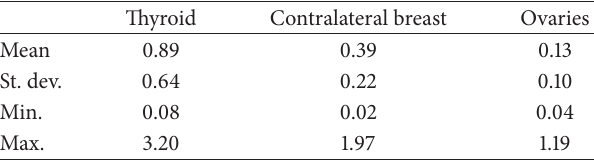
Table 2: Doses [cGy] for 196 PBI (bilateral not